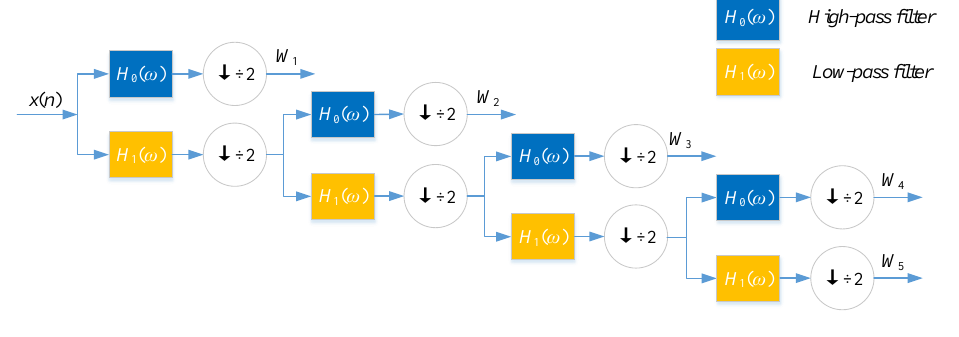
Figure 5. Wavelet decomposition